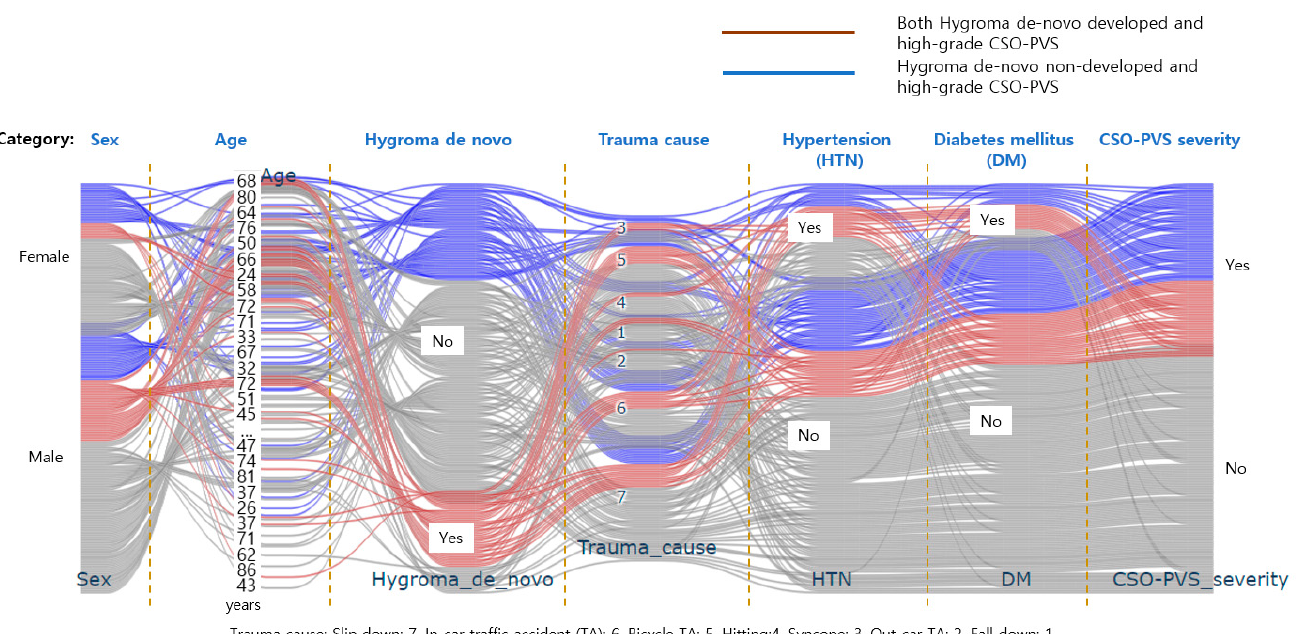
Figure 4. Hierarchical analysis of the relationship between CSO-PVS severity and the risk factors. The red lines show cases with de novo hygroma with high-grade CSO-PVS. However, blue lines show cases without de novo hygroma with high-grade CSO-PVS.